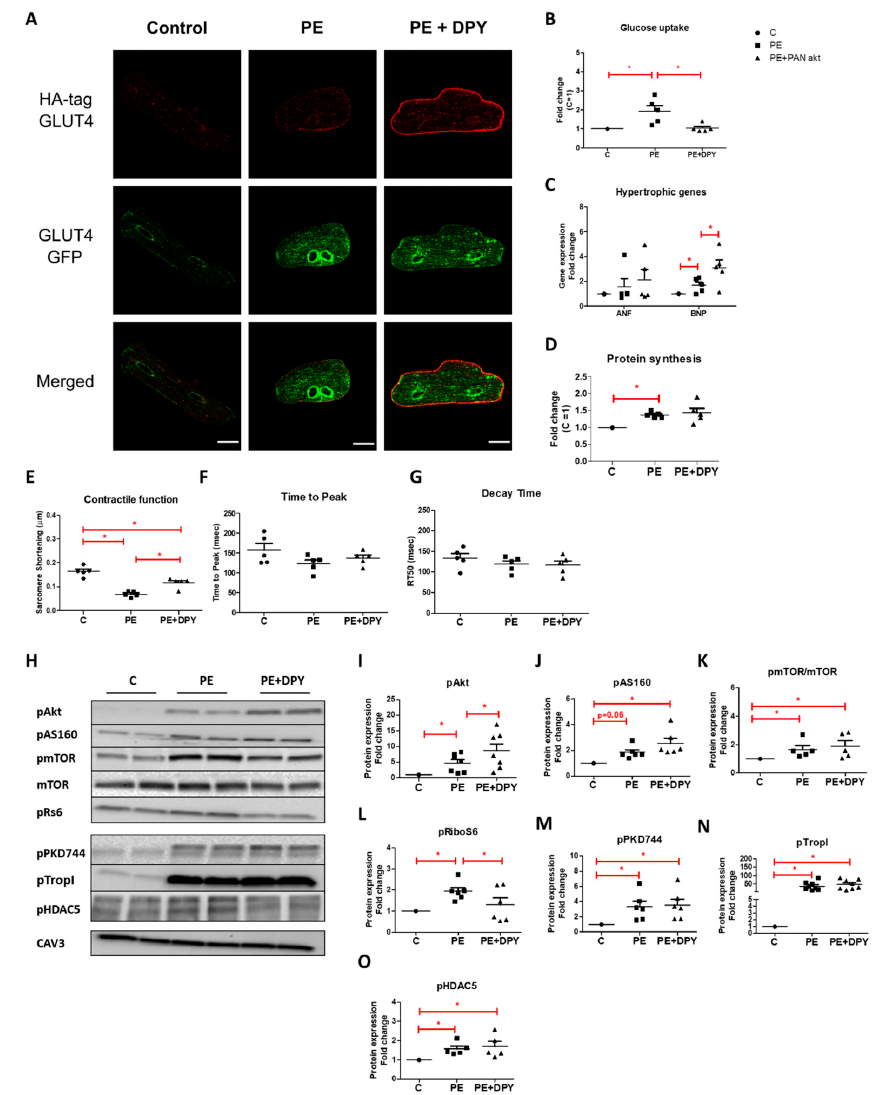
Figure 6. The effect of dipyridamole (DPY) (10 µM) on GLUT4 translocation, glucose uptake, hypertrophic gene expression, protein synthesis, contractile function, and cellular signaling after 24 h stimulation with phenylephrine (50 µM). GLUT4 translocation (scale bar 20 µm) (representative confocal images of n = 3, also see Supplemental Figure S2) ( A ), glucose uptake ( n = 5) ( B ), hypertrophic gene expression ( n = 5) ( C ), and protein synthesis ( n = 5) ( D ) are displayed in fold increase relative to control. ( E – G ) Contractile properties upon 1 Hz electric-field stimulation: sarcomere shortening, time to peak, and decay time. Values are expressed as means ± STDEV ( n = 5). ( H ) Representative Western blots depicting phosphory- lation levels of proteins involved in the Pi3K/Akt/mTOR-pathway (p-Akt(Ser473), p-AS160(Thr642), p-mTOR(ser2448), and p-rS6(Ser235/236)) and the PKD1-pathway (p-PKD1(ser744), p-TropI(Ser23/24), and p-HDAC5(Ser498)). ( I – O ) For quantification, protein levels were normalized to Caveolin 3 (CAV3). Values are expressed as fold increase ± STDEV relative to control ( n = 5/ n = 7). * p < 0.05 was considered significantly different compared to